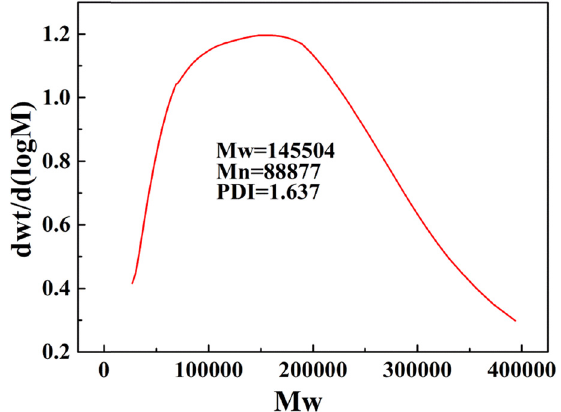
Figure 4: GPC curve of SiO 2 @AR -